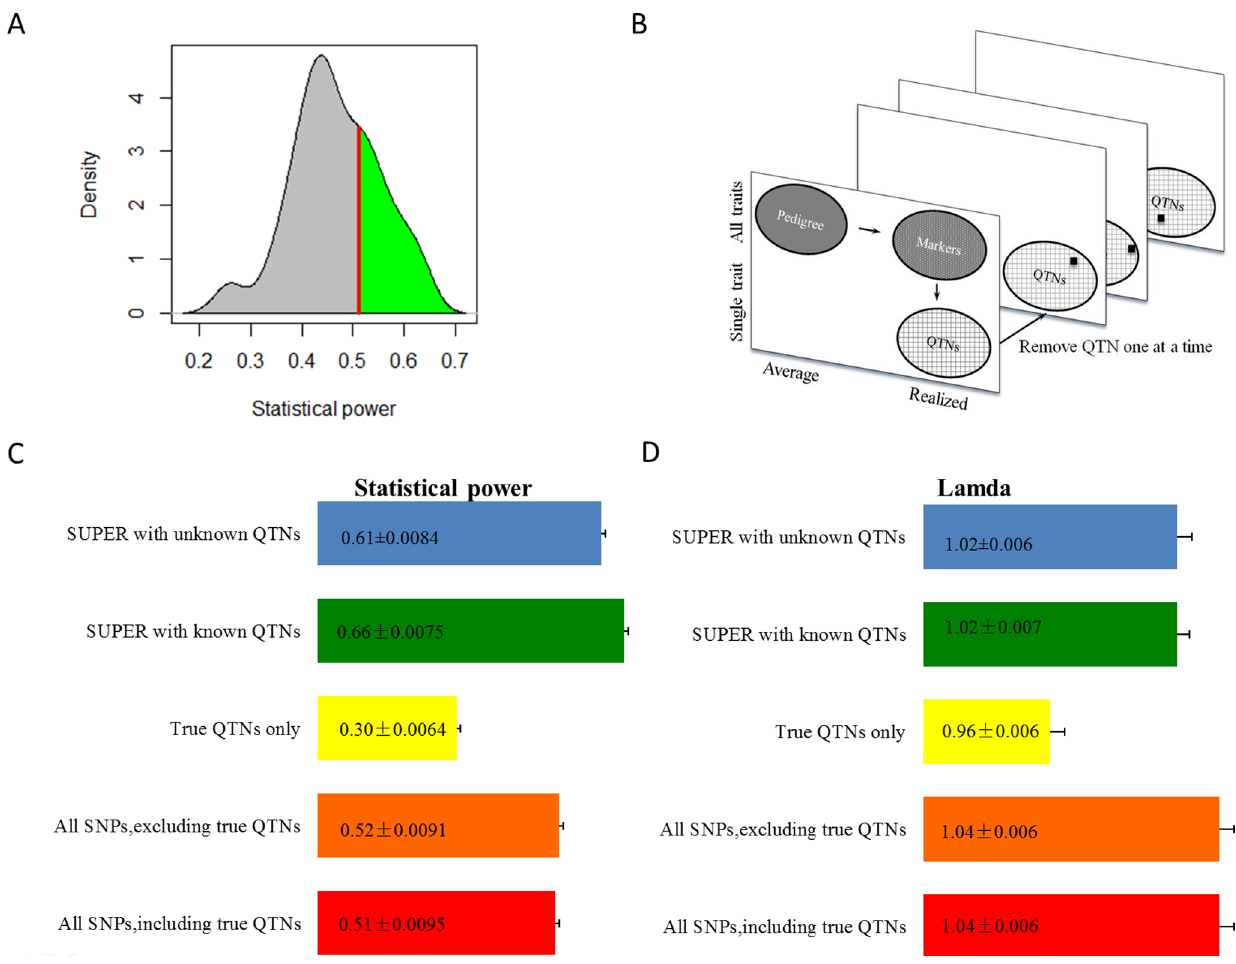
Figure 1. Conception and performances of different methods. A ) Distribution of statistical power by using a kinship derived from a set of SNPs selected randomly. The dataset contained , 3,000 SNPs genotyped on 282 maize inbred lines. The number of selected SNPs was the same as the number of individuals used to derive kinship. Power was examined on a trait simulated from 27 causative mutations, i.e. Quantitative Trait Nucleotide (QTNs), sampled from the , 3,000 SNPs except the ones on the last chromosome. The SNPs on the last chromosome were used to derive the null distribution of Type I error. The heritability of the trait was set to 0.75. A total of 100 replications were conducted. The average and the median power are 0.476 and 0.444. The power of using kinship derived from all SNPs is 0.511 (red line). B ) Conception of kinship for association study. Pedigree is the first available information used to calculate kinship. It is the expectation for a pair of individuals to be identical by descent at any locus, (e.g., full siblings have a kinship of 50% in cases of no inbreeding). Pedigree kinship can be used across traits. A realized kinship derived from genetic markers covering entire genome is more precise than pedigree based (e.g., full siblings could have a kinship of 60% - or 40% - instead of 50%). However, it is still general and can be used for all traits. A complete trait specific realized kinship is using all the QTNs underlying the trait. This complete trait specific kinship is ideal for genome prediction, but not for GWAS. The ideal kinship for GWAS is its complement (using all QTNs except the one being tested) to remove the confounding between the kinship and the tested SNPs. C ) and D ) display the performance of statistical power and effectiveness of genomic control of inflation factor by using different kinship. The statistical power is about 50% when using all the SNPs. Inclusion or exclusion of the 27 QTNs did not have a significant impact. When only the 27 QTNs were used to derive a complete trait specific kinship, the statistical power was dramatically reduced to 30%. When each of the 27 QTNs was tested by using the complementary trait specific kinship derived from the other 26 QTNs (SUPER with known QTNs), the statistical power was boosted to 66%. A statistical power of 61% was retained by using SUPER with masked QTNs. The genomic control of SUPER was similar with known QTNs and with masked QTNs, closer to expectation (1.00) than other